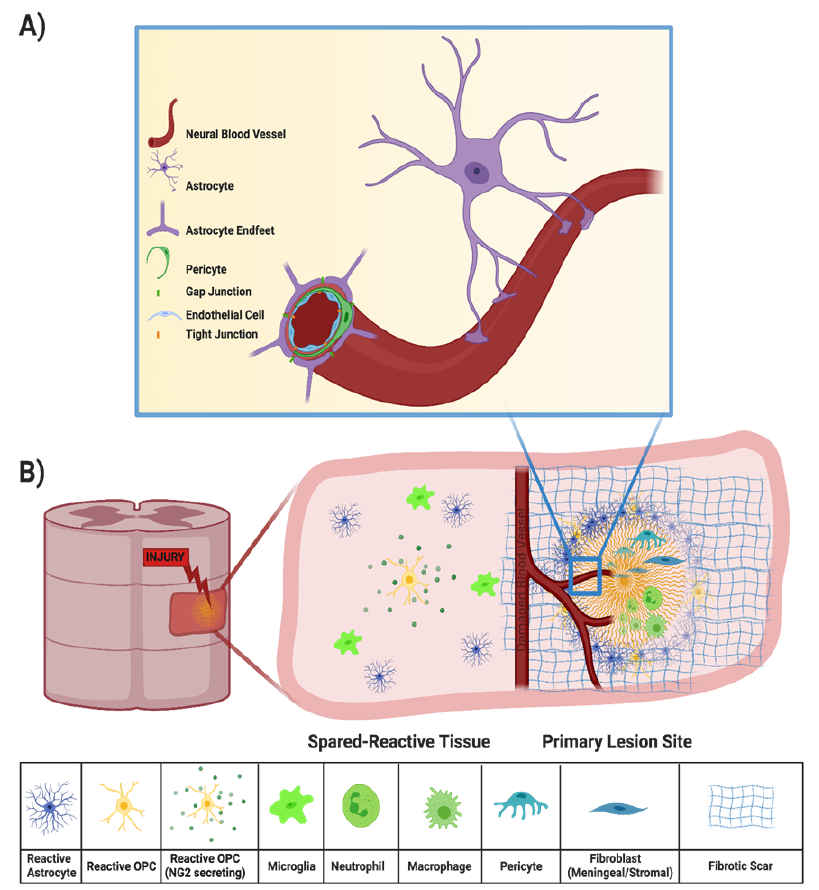
Figure 2. ( A ) Components of the BSCB, in which the neural blood vessel is composed of endothelial cells surrounded by pericytes and end feet of astrocytes that tightly regulate entry of drugs, solutes, and cells into the CNS. ( B ) Components of the secondary injury response, in which a compromised BSCB results in entry of peripheral immune cells, recruitment of microglia, reactive astrocytes, OPCs, and fibroblasts, and fibrotic scar